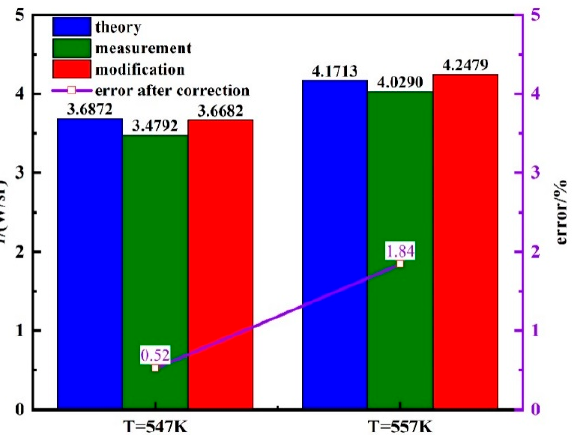
accuracy and verifying the effectiveness of the correction method.